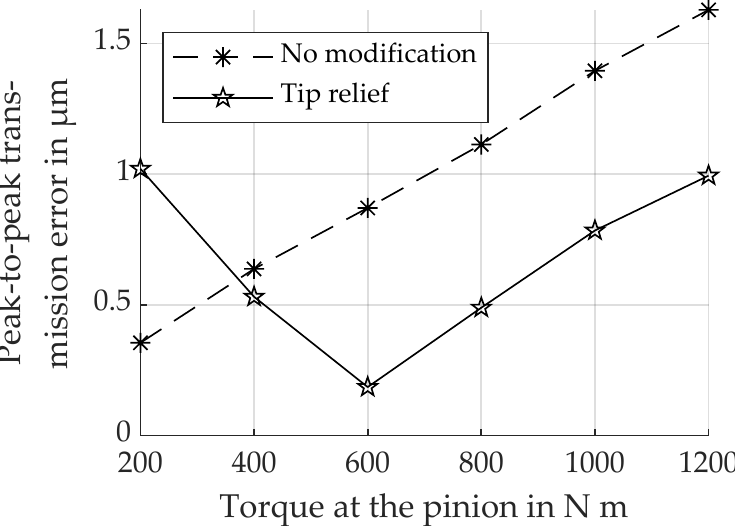
Figure 2. Peak-to-peak transmission error of the gear pair used in the